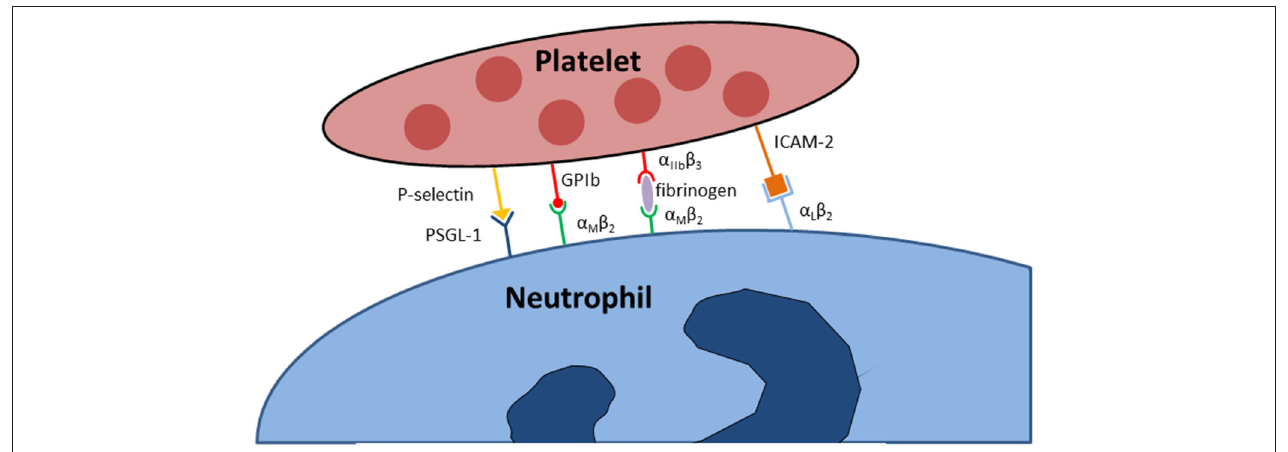
FIGURE 1 | Adhesion molecules implicated in the physical interaction between neutrophils and